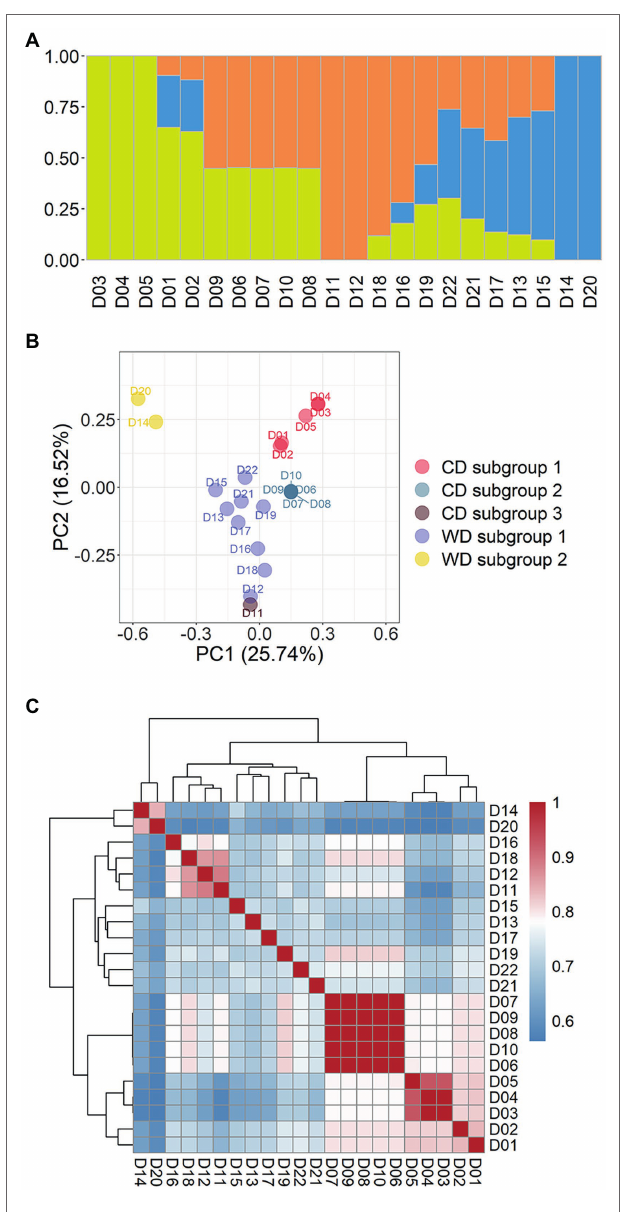
FIGURE 3 | Population structure of 22 Flammulina filiformis dikaryons. (A) The 22 strains contained 3 ancestral genetic components and their proportions, and different colors represented different ancestral genetic components. (B) PCA plot of 22 F. filiformis dikaryons. (C) Identity-by-Stat (IBS) was used to analyze the genetic relationship of 22 F. filiformis